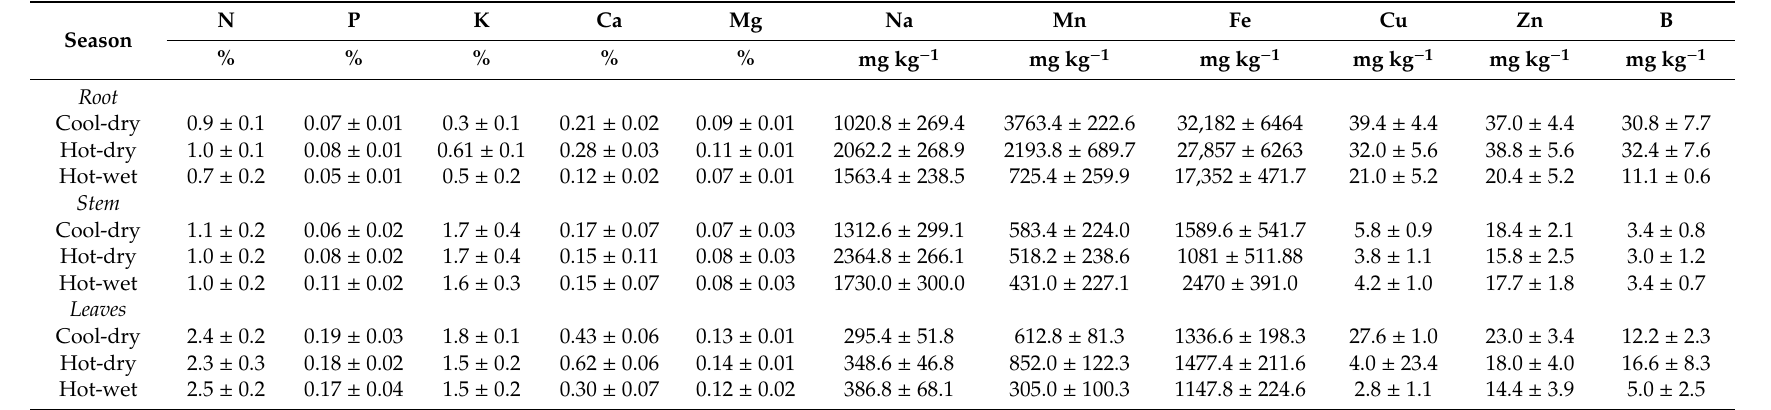
Table 3. Mean nutrient and metal concentration recorded in di ff erent plant parts of Phragmites australis sampled from Mvudi River, South Africa.